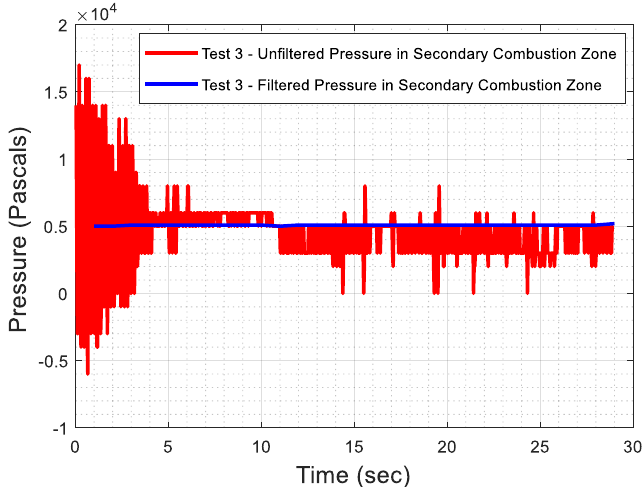
Figure 20. Pressure in Secondary Combustion Zone vs. Burn Time.